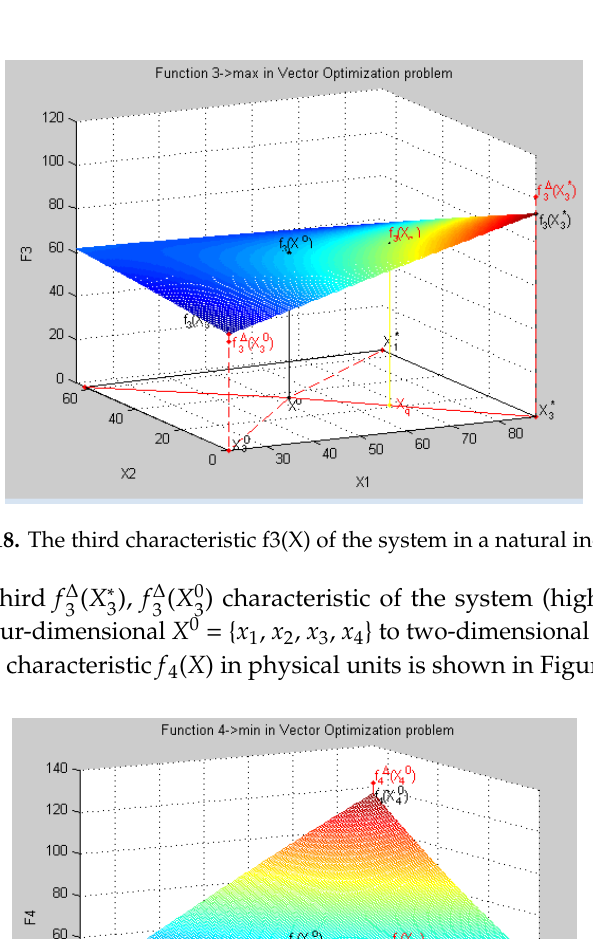
Figure 17. The second characteristic f 2 (X) of the system in a natural indicator.